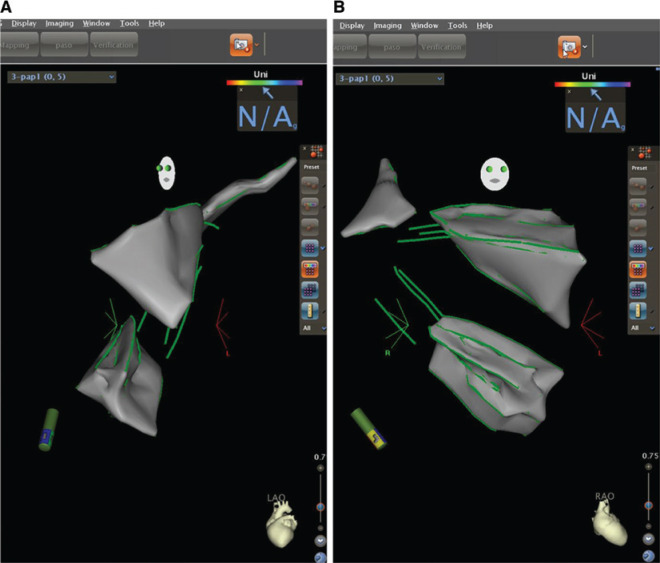
Three-dimensional echocardiograph reconstruction of the mitral valve and papillary muscles with CartoSOUND™ (Biosense Webster, Diamond Bar, CA, USA). A: Left anterior oblique view. B: Right anterior oblique view.